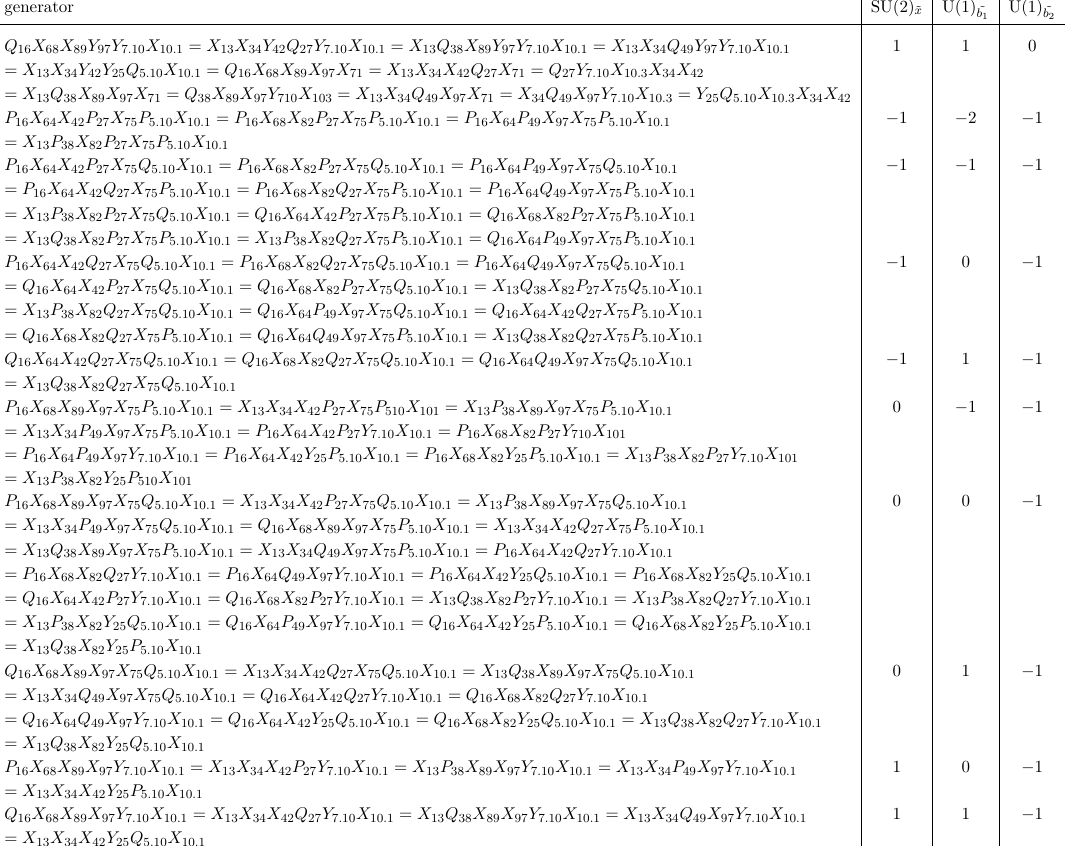
Table 54 . The generators in terms of bifundamental chiral fields for Model 13 (Part 2)